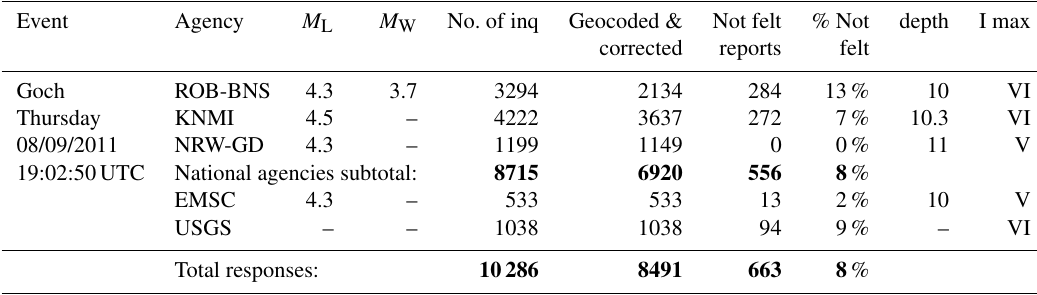
Table 1. Institutional macroseismic data for the 2011 Goch earthquake. When street addresses were available, response locations were geocoded for location improvement. Intensities were floor-level corrected. Only total amount of geocoded and corrected intensity points are used for grid cell intensity analysis in this study. M L : local magnitude; M W : moment magnitude; no. of inq: number of inquiries; I max: maximum intensity.